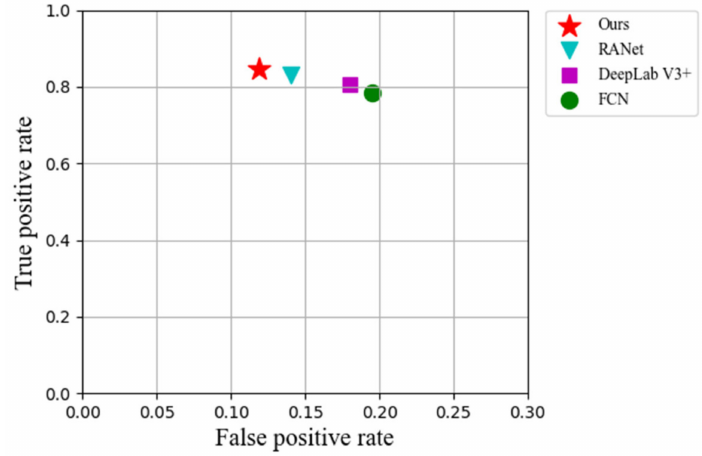
Figure 9. Receiver operating characteristic (ROC)